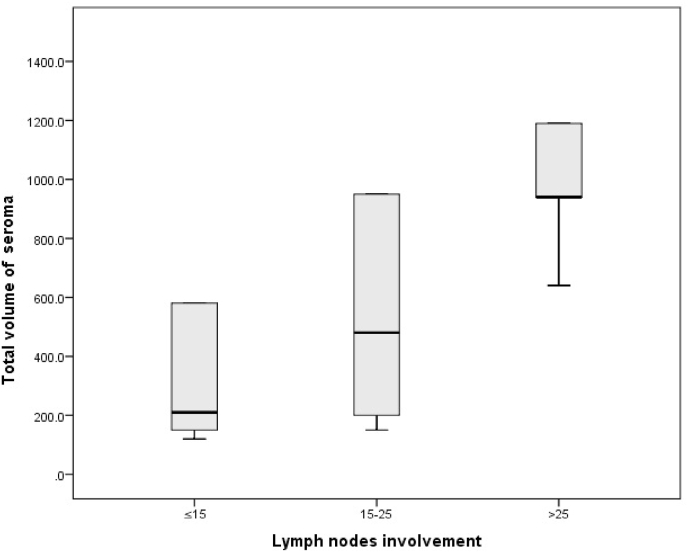
Association between total volume of seroma and lymph nodes involvement.